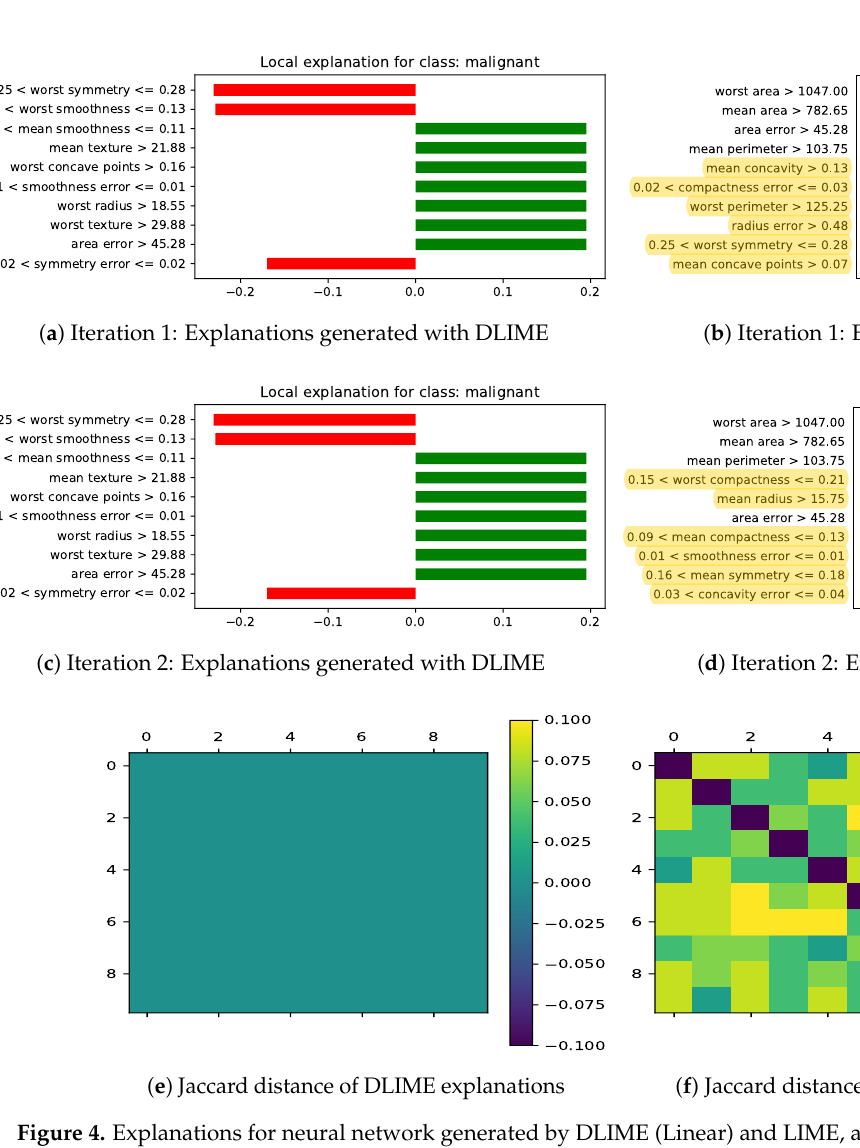
Figure 4. Explanations for neural network generated by DLIME (Linear) and LIME, and respective Jaccard distances over 10 iterations. Highlighted features with yellow color in ( b , d ) represents the difference in selected features for the same instance over 2 iterations. The order of features in ( a – d ) is higher to lower importance. ( e , f ) shows the Jaccard distance matrix among the features selected over 10